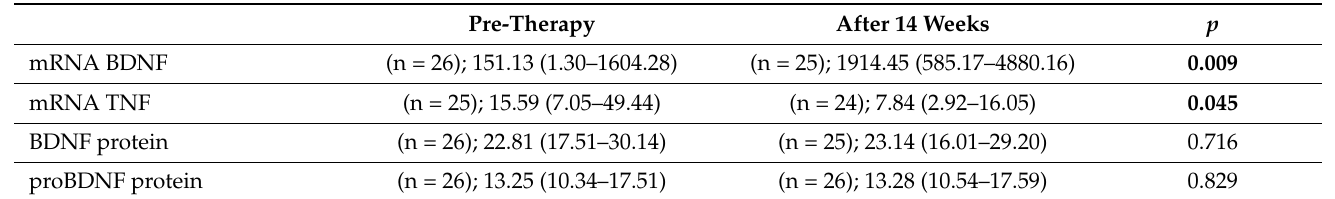
Table 5. Comparison between level of neurotrophin expression before and after anti-TNF therapy.